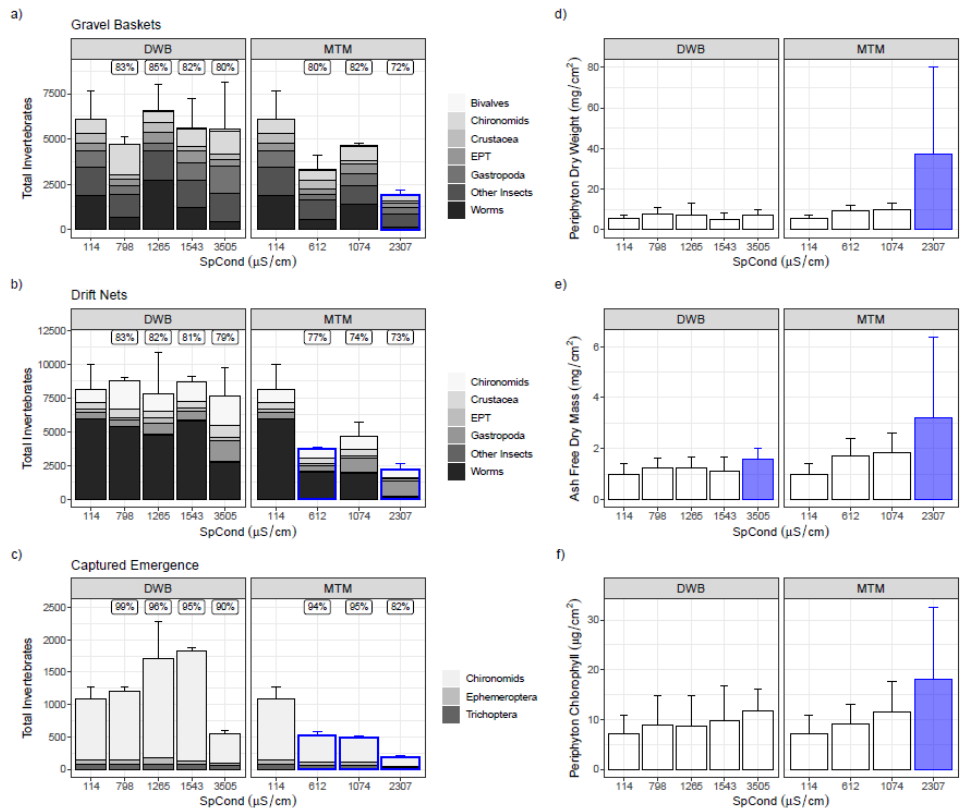
Figure 8. System-level measures: Total invertebrates counted from sampled gravel baskets ( a ), drift net deployments ( b ), and captured emergence ( c ) by recipe and dose. Percentages at top of graphs are Bray – Curtis similarities between specific dose and control based on Taxa1 assemblages. Dosing period average bulk periphyton responses, including total dry weight ( d ), ash free dry mass ( e ), and chlorophyll ( f ). Bars with blue are significantly different from control dose ( p < 0.05) per Dunnett’s test. Data are means of two replicate mesocosms ± 1 sd.